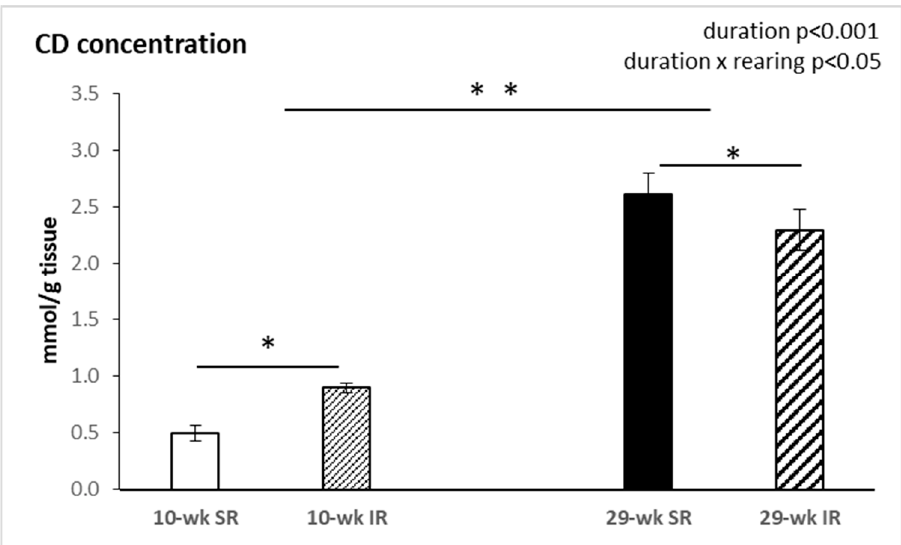
Figure 5. Effects of isolation rearing conditions on concentration of conjugated dienes in cortex posterior to PFC. 10–wk SR, 10 week socially reared SD rats; 10–wk IR, 10 week isolation reared SD rats; 29–wk SR, 29 week socially reared SD rats; 29–wk IR, 29 week isolation reared SD rats; PFC, prefrontal cortex; SD, Sprague Dawley. Data are expressed as the mean ± SEM. Statistical significance as revealed by two-way ANOVA with subsequent Sidak post-hoc test when appropriate: * p < 0.05, ** p < 0.001.